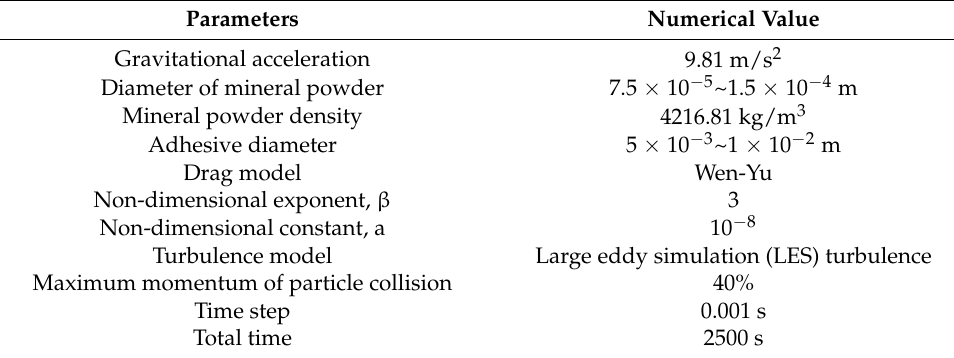
Figure 3. Particle size distribution. Table 3. Input parameters in the CPFD